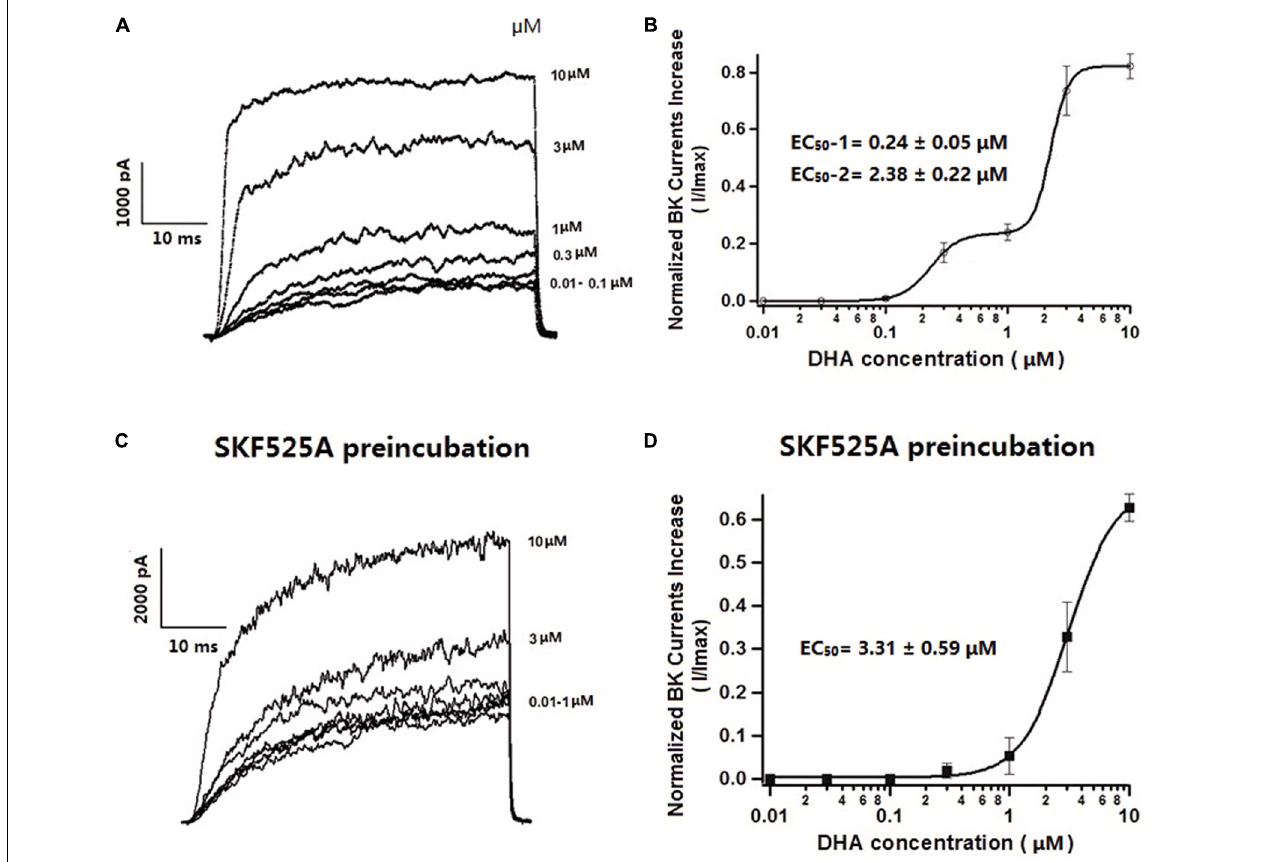
FIGURE 2 | Effects of different concentrations of DHA on BK currents and the role of CYP in mediating DHA activation on BK currents in rat CASMCs. (A) Representative current traces showing BK currents at baseline and after exposure to 3 and 10 µ M of DHA. (B) Concentration–response relationships showing the effects of DHA on BK channel activation, n = 6 cells. (C) Representative current traces showing BK currents at baseline and after exposure to 3 and 10 µ M of DHA in rat CASMCs after incubation with 10 µ M SKF525A for 60 min. (D) Concentration–response relationships showing the effects of DHA on BK channel activation with SKF525A pre-incubation, n = 6